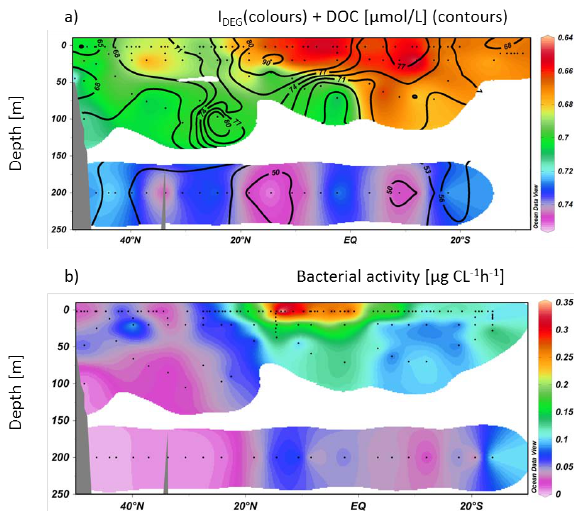
Fig. 8. (a) Values of the degradation index I DEG for SPE-DOM samples from the eastern Atlantic Ocean (colors) and bulk DOC concentrations (contours); (b) the bacterial activity determined as utilized µgCl − 1 h − 1 in the upper 250m of the water column in the eastern Atlantic Ocean. I DEG can be easily calculated and used to estimate and compare the degradation state of marine FT-ICR MS analyzed SPE-DOM. The higher the values of I DEG , the more degraded is the SPE-DOM. I DEG and the DOC concentrations are significantly correlated. The bacterial activity maximum coincides with the lowest I DEG , the DOC maximum and the youngest SPE- DOM (Fig.